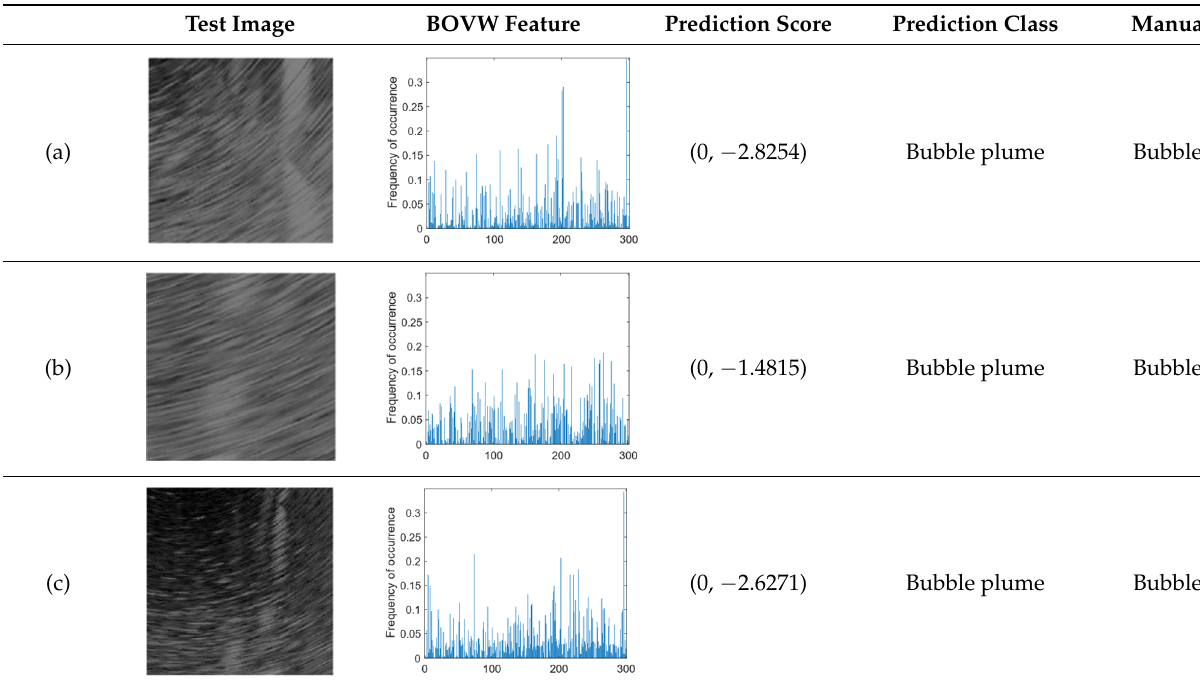
Table 5. Prediction results of water column images set using BOVW features.